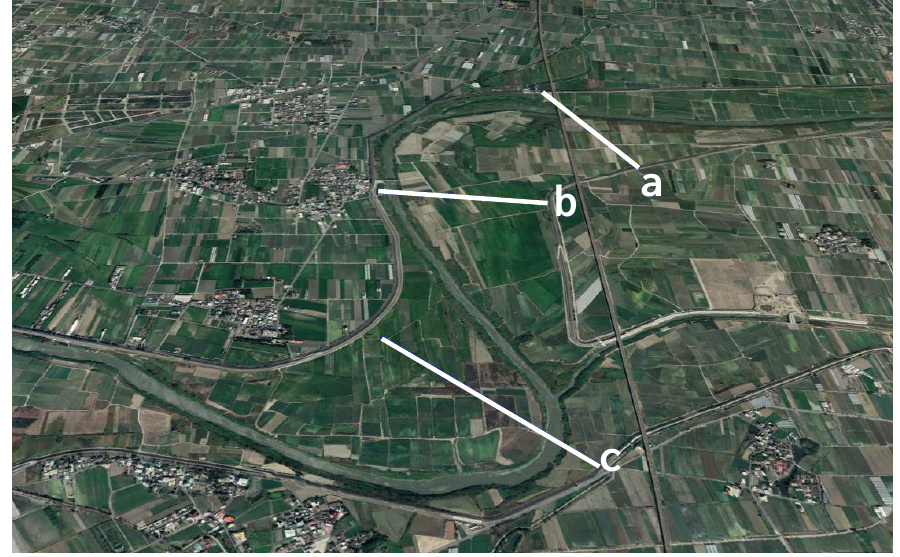
Figure 4. Simulation zone and compared cross-section ( a – c ) of Beigang River.